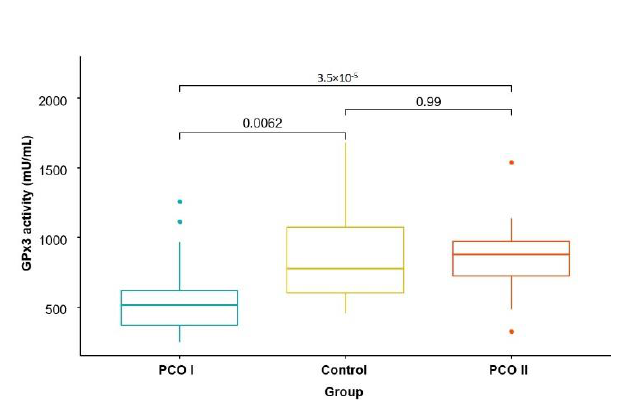
Figure 1. Comparison of FRAP ( a ), uric acid levels ( b ), and GPx3 ( c ) activity in the plasma of women with PCOS before dietary intervention (PCO I), women with PCOS after dietary intervention (PCO II), and women not diagnosed with PCOS (control). The means were compared using the Kruskal–Wallis test. Table 2. Correlation matrix between anthropometric and biochemical parameters and antioxidants (uric acid, FRAP, GPx3) in women with PCOS.